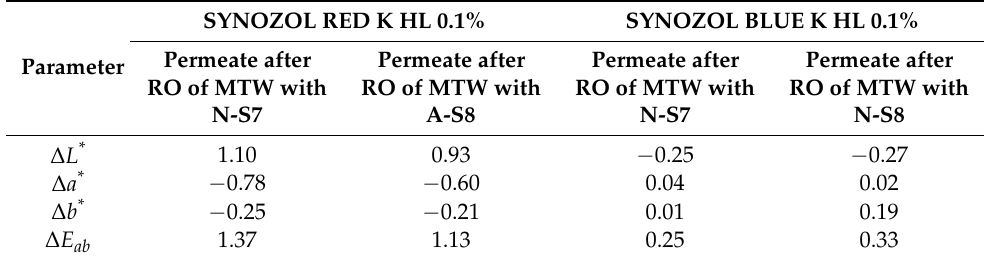
Table 6. Color difference ( ∆ E ab ) of dyed samples with a color intensity of 1.0% in pure water and treated MTW: knitted fabric 100%